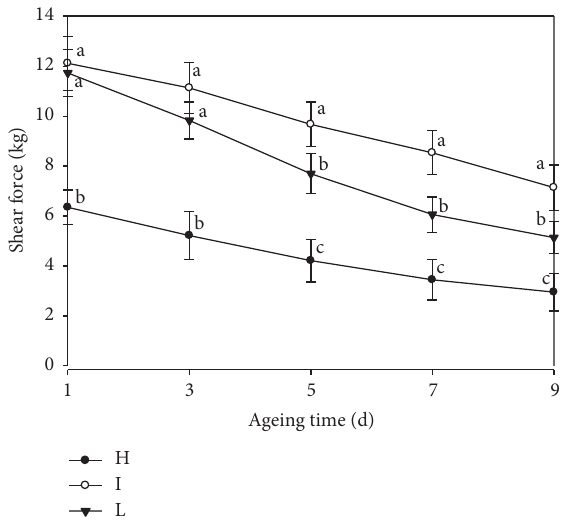
Figure 1: Effect of ultimate pH (pHu) and ageing time on